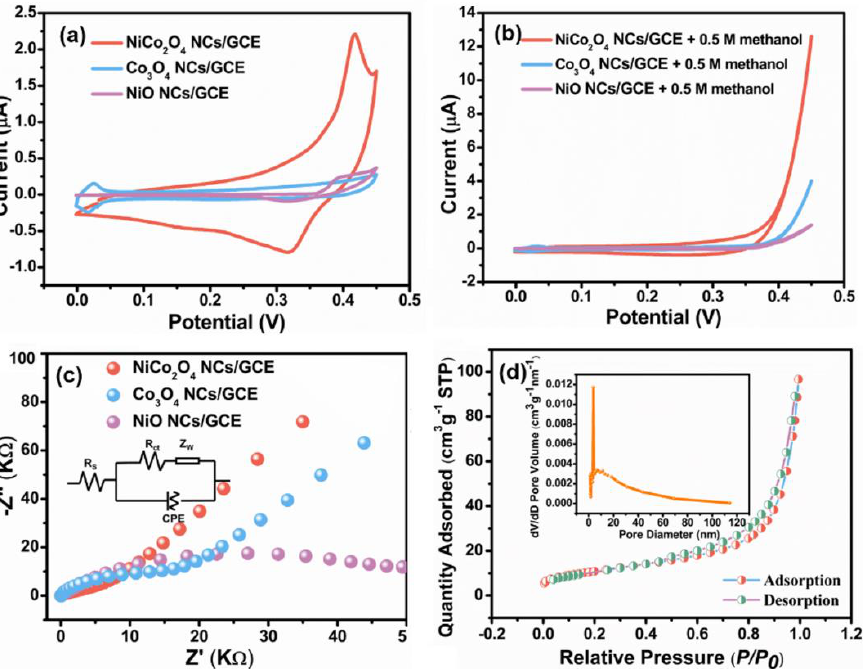
Figure 5. CV curves of NiCo 2 O 4 NCs/GCE, Co 3 O 4 NCs/GCE and NiO NCs/GCE in 1 M KOH ( a ) without methanol and ( b ) with 0.5 M methanol at 50 mV s − 1 ; ( c ) EIS plots of NiCo 2 O 4 NCs/GCE, Co 3 O 4 NCs/GCE and NiO NCs/GCE in 1 M KOH with 0.5 M methanol; ( d ) N 2 adsorption– desorption isotherms of the NiCo 2 O 4